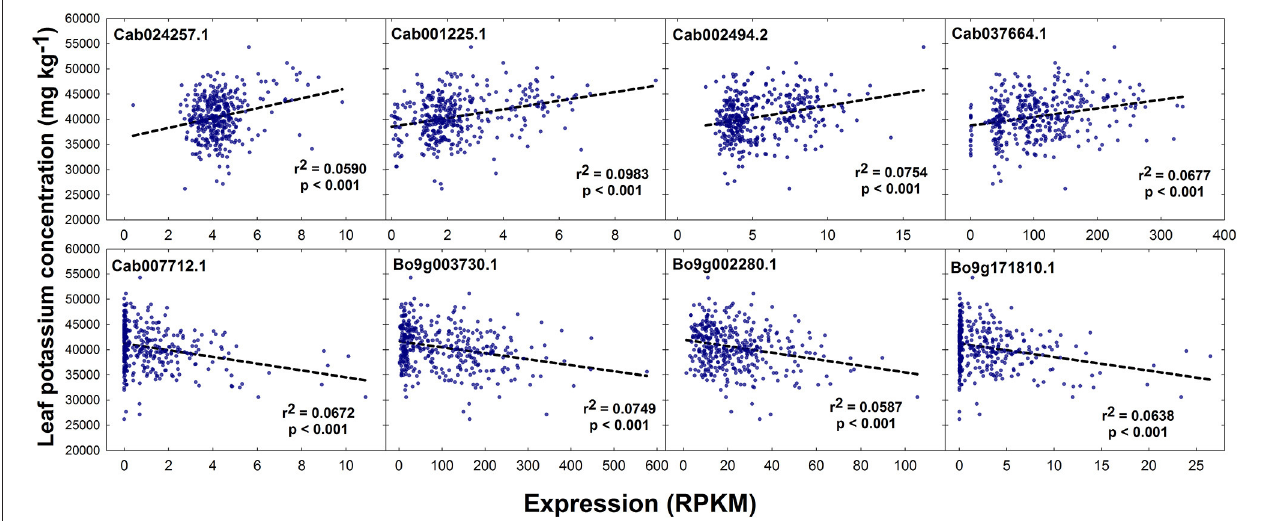
FIGURE 5 | Effect of leaf transcript abundance of genes underlying candidate GEMs on leaf potassium concentration. Transcript abundance was quantified and normalized as reads per kb per million aligned reads (RPKM) for each genotype. r 2 values and respective significance values calculated in GenStat are